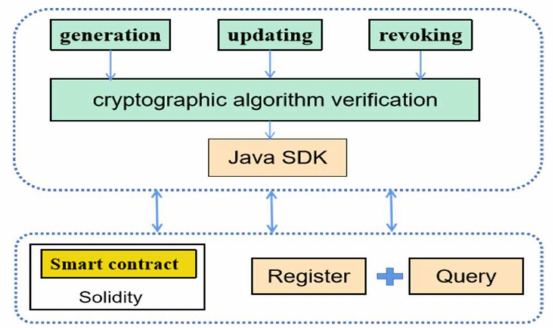
Figure 7. The experimental